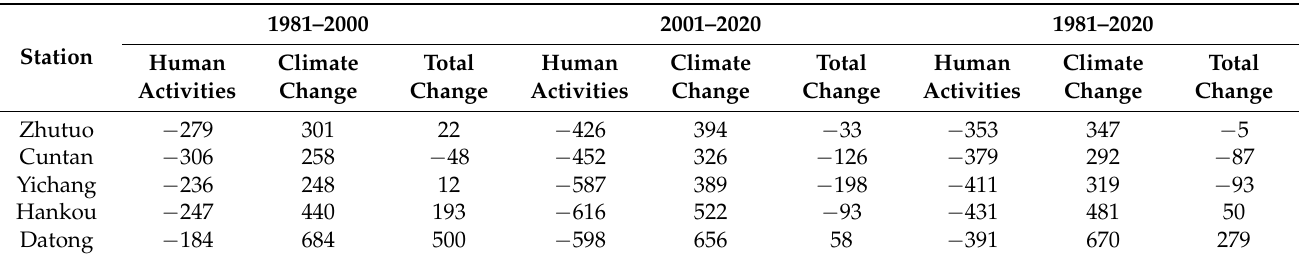
Table 5. Variations of annual runoff caused by climate change and human activities, compared with the natural period (1961–1980) *.